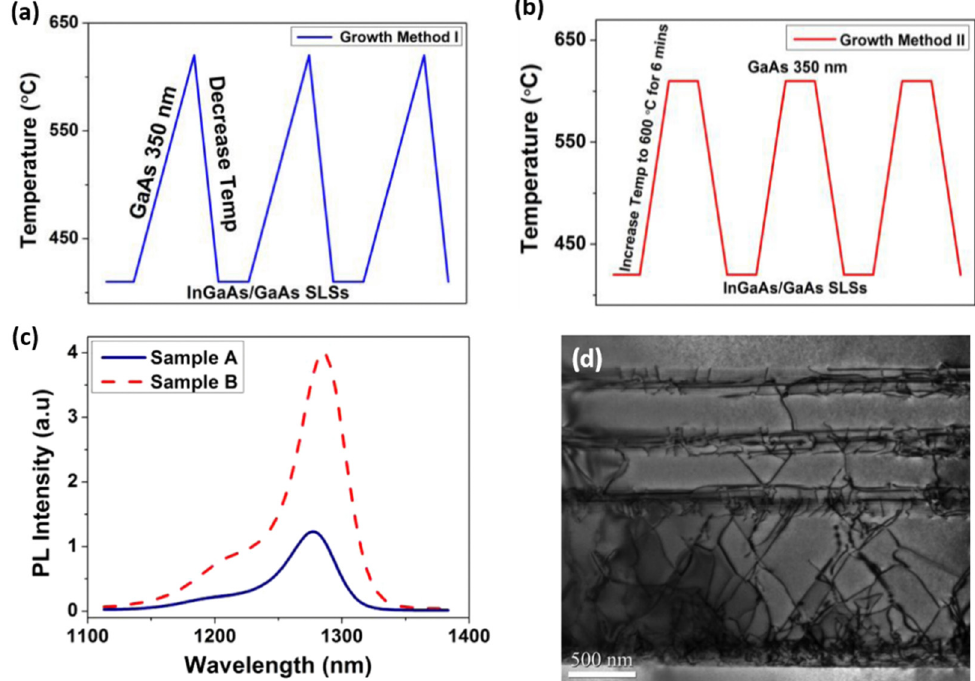
Figure 15. ( a ) Growth method I: The GaAs spacer layer was grown during the ramp-up of temperature from 420 to 610 °C and then cooled down to 420 °C for subsequent growth of InGaAs/GaAs strained-layer superlattices (SLSs) ( b ) Growth method II: The GaAs spacer layer was not grown during the ramp-up of temperature from 420 to 610 °C, and grown only at a stable temperature of 610 °C and then cooled back to 420 °C for subsequent InGaAs/GaAs SLSs growth. ( c ) PL spectra measured at room temperature of sample A (growth method I) and B (growth method II). ( d ) Dark-field cross-sectional TEM image of optimized three layers of defect filter layers (DFLs). Reprinted from Reference [224] © 2016 The authors, under CC BY.